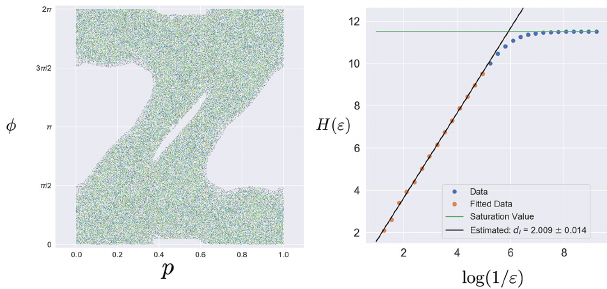
FIG. 7. Left: chaotic orbit with dynamic generated by the stan- dard map at K = 2 and initial conditions ( p 0 , φ 0 ) = ( 0.1, 4 π/ 10 ) . Right: numerical estimation of the information dimension, as above. Again, the estimated value is consistent, up to two significant digits, with the expected one of D = 2.